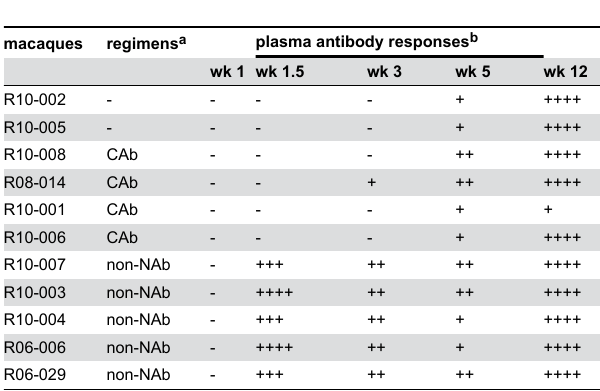
Table 1. SIV-specific antibody responses in plasma after SIV infection.